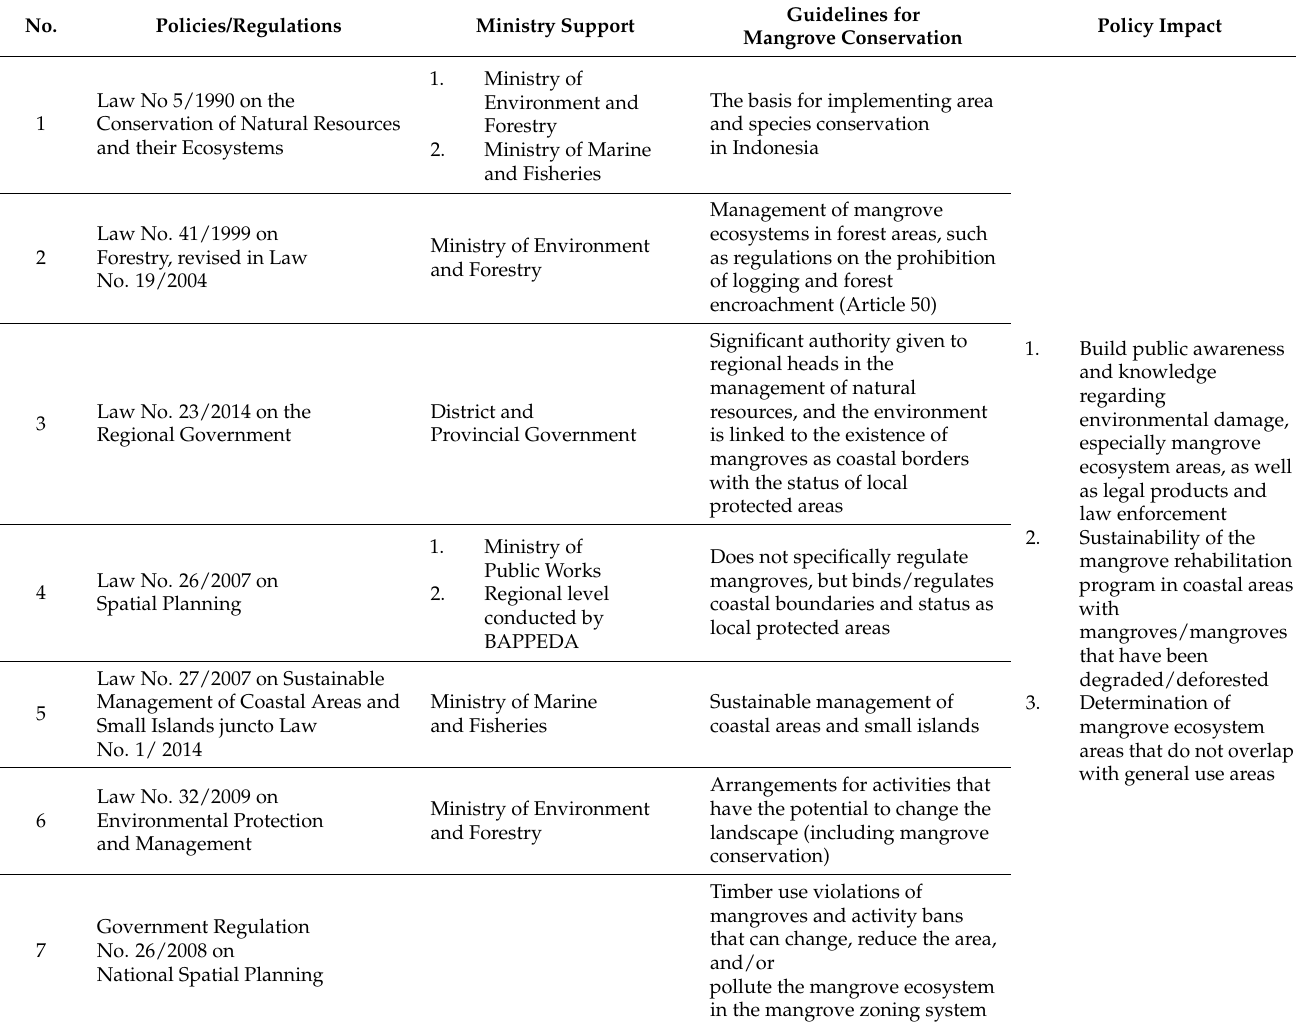
Table 1. Government policies on mangrove forest management in Indonesia